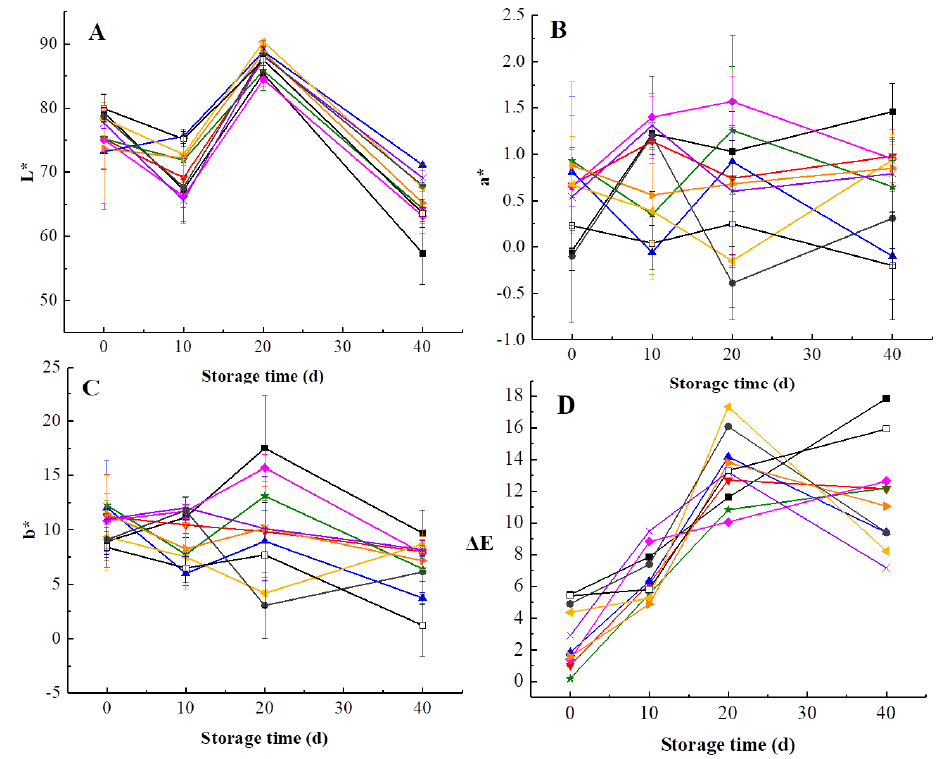
Figure 3. Changes in color of heat-treated and HHP-treated kiwifruit pulp beverage during storage at 4 °C for 40 days. ( A ) L*, the brightness value on a black (0) to white (100) scale; ( B ) a*, hue on a green ( − ) to red (+) scale; ( C ) b*, hue on a blue ( − ) to yellow (+) axis; ( D ) ∆ E, the total color difference between treated samples and untreated samples at the initial time. Heat treatment (85 °C for 10 min) ( ■ ), HHP (high hydrostatic pressure, 400–600 MPa for 5–15 min): 400 MPa/5 min ( ▼ ), 400 MPa/10 min ( ▲ ), 400 MPa/15 min ( ★ ), 500 MPa/5 min ( ◆ ), 500 MPa/10 min ( ◀ ), 500 MPa/15 min ( ▶ ), 600 MPa/5 min ( × ), 600 MPa/10 min ( ● ), 600 MPa/15 min ( □ ). All data were expressed as means ± SD, n = 3.